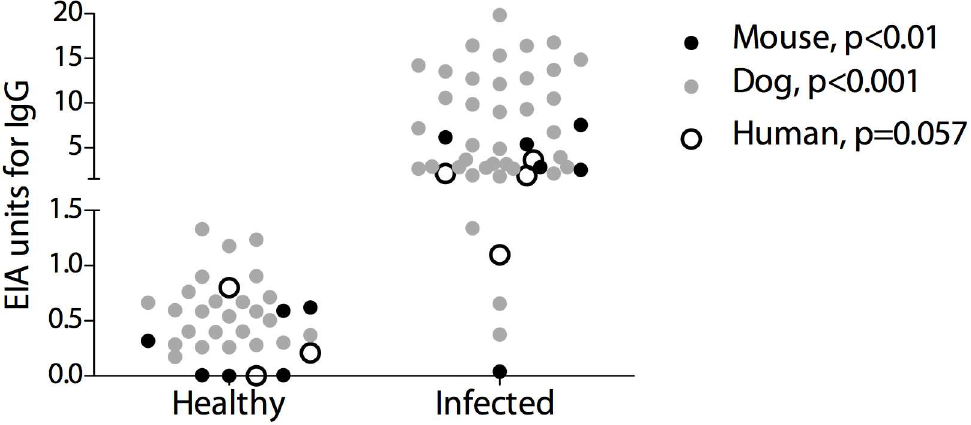
Fig 1. Detection of IgG antibodies against Coccidioides from multiple mammalian species using protein A/G. EIA units from healthy and Coccidiodes -infected mouse, dog, and humansera/plasmasamples. The y-axis is split with a scale of 0–1.5 EIA units and of 1.5–20EIA